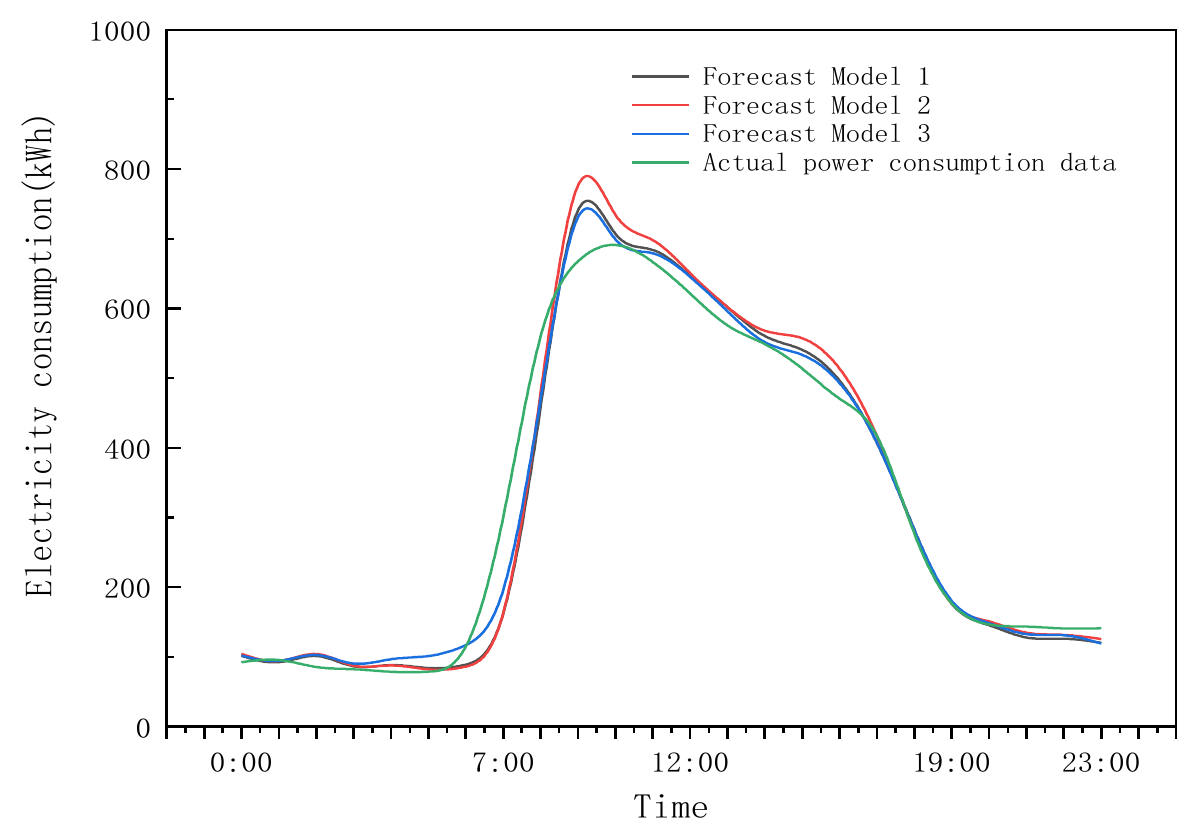
Figure 12. Forecast of the air-conditioning electricity consumption on a working day. As shown in Figure 12, the prediction models 1, 2, and 3 represent those with only historical electricity data, those with the addition of ‘dry bulb temperature’, and those with ‘schedule’, or relative humidity. At 7:00. on weekdays, the actual electricity consumption data significantly increased. Model 3 reflects this change more accurately than the other two models. Model 3 is closer to the actual electricity consumption data than the other two models in the subsequent predictions. After a day of accumulating energy consumption data, the actual air-conditioning power consumption was 7682 kWh, the total predicted power consumption of Model 3 was 7695 kWh, the total predicted power consumption of Model 1 was 7619 kWh, and the total predicted power consumption of Model 2 was 7798 kWh. Next, we discuss whether the above parameter adjustment method can be applied to other office buildings. We used the energy consumption data of another office building in Shanghai from 2015 to 2017 and used the same method to recalculate and verify the office building. The final prediction accuracy results are listed in Table